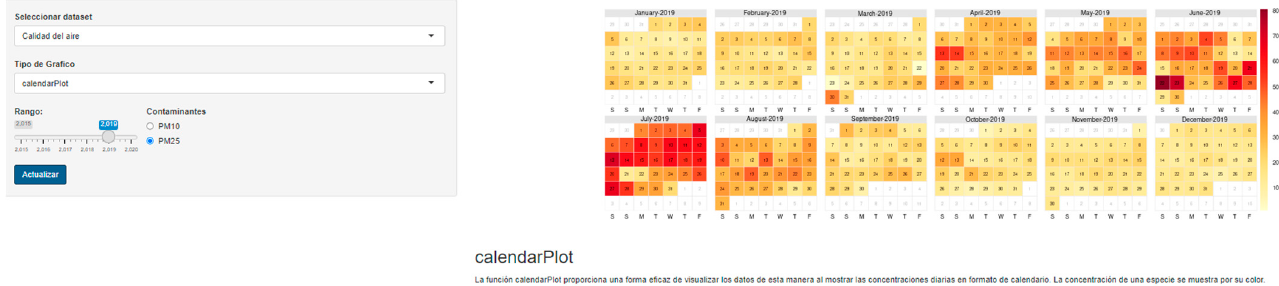
Figure A5. PM25 calendar plot for combined monitoring stations in 2019. The polarPlot function plots a bivariate polar graph of how concentrations vary with wind speed and direction. Figure A6 represents the polar graph for the monitoring stations La Florida (LF) and Parque O’Higgins (SA).